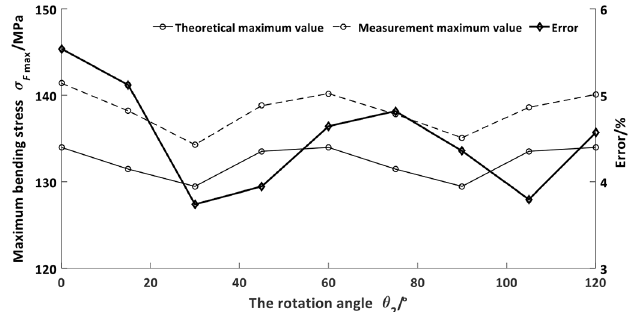
Fig. 19. Theoretical maximum value and measurement max- imum